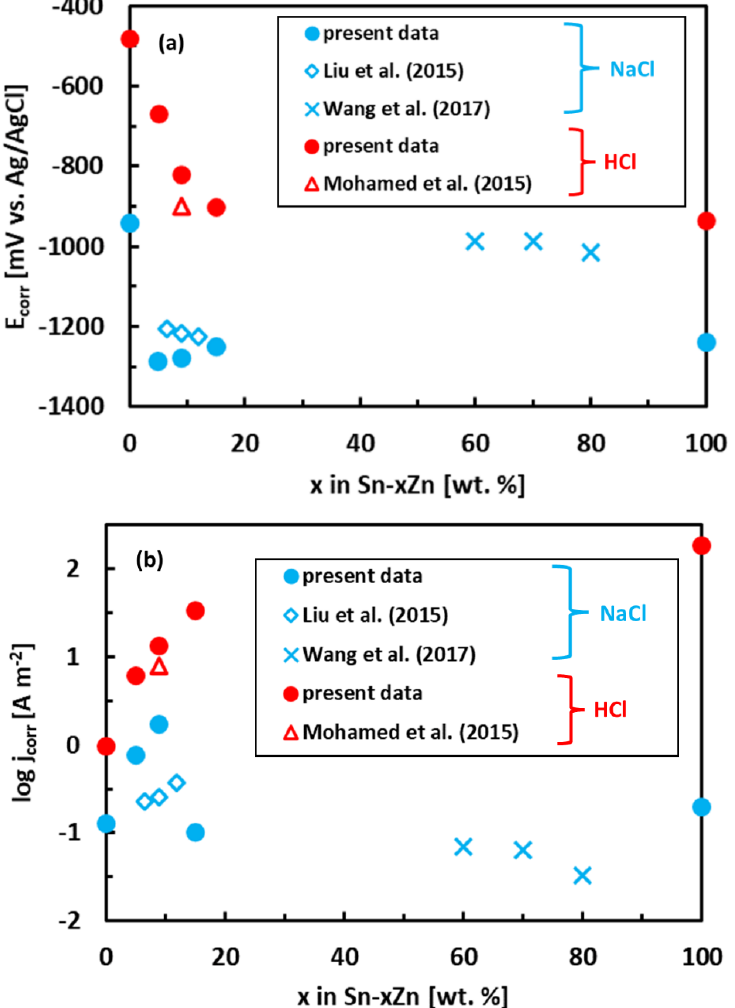
Figure 6. Corrosion parameters of Sn–Zn alloys: corrosion potential ( a ) and corrosion current density ( b ). Results of the present work are compared with ref. [15,19,46]. Table 2. Physicochemical properties and experimental corrosion parameters of the Sn – xZn alloys studied in this work.